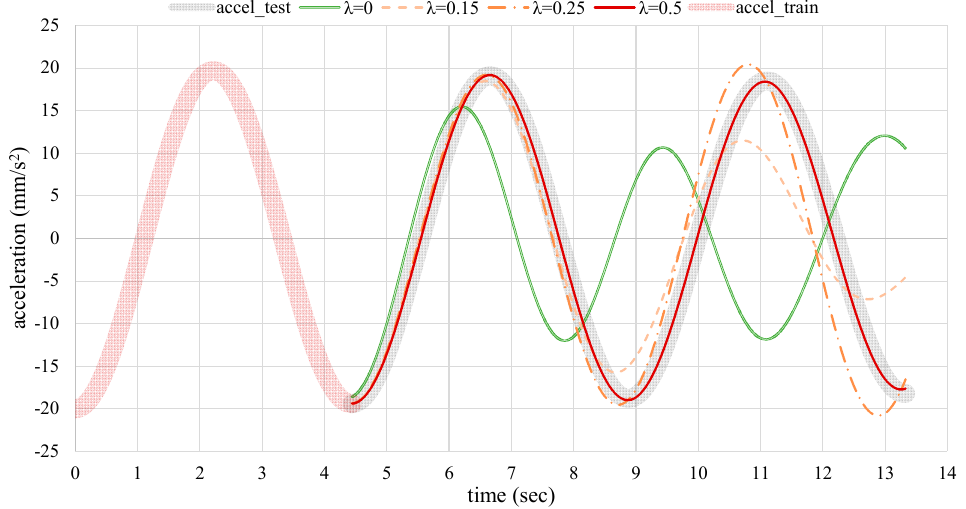
Figure 13. Acceleration estimation of the PINN for various λ and the ANN with λ = 0 during the test period.